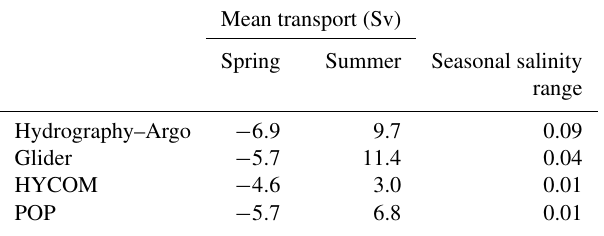
Table 3. Mean transport and seasonal salinity range of the un- dercurrent (200–1000m) across 8 ◦ N in boreal spring (February to mid-April as highlighted by white lines in Fig. 3) and sum- mer (June to mid-August as highlighted by yellow lines in Fig. 3) from hydrography–Argo profiles, glider measurements, HYCOM, and POP. Seasonal salinity range is the approximate difference be- tween boreal spring and summer extremes in average seasonal cy- cle. Note that the statistics representing glider measurements are derived from gridded velocity referenced to its depth-averaged ve- locity (e.g., Fig. 2) and salinity interpolated onto 8 ◦ N. Mean transport (Sv) Spring Summer Seasonal salinity range Hydrography–Argo − 6 . 9 9.7 0.09 Glider − 5 . 7 11.4 0.04 HYCOM − 4 . 6 3.0 0.01 POP − 5 . 7 6.8